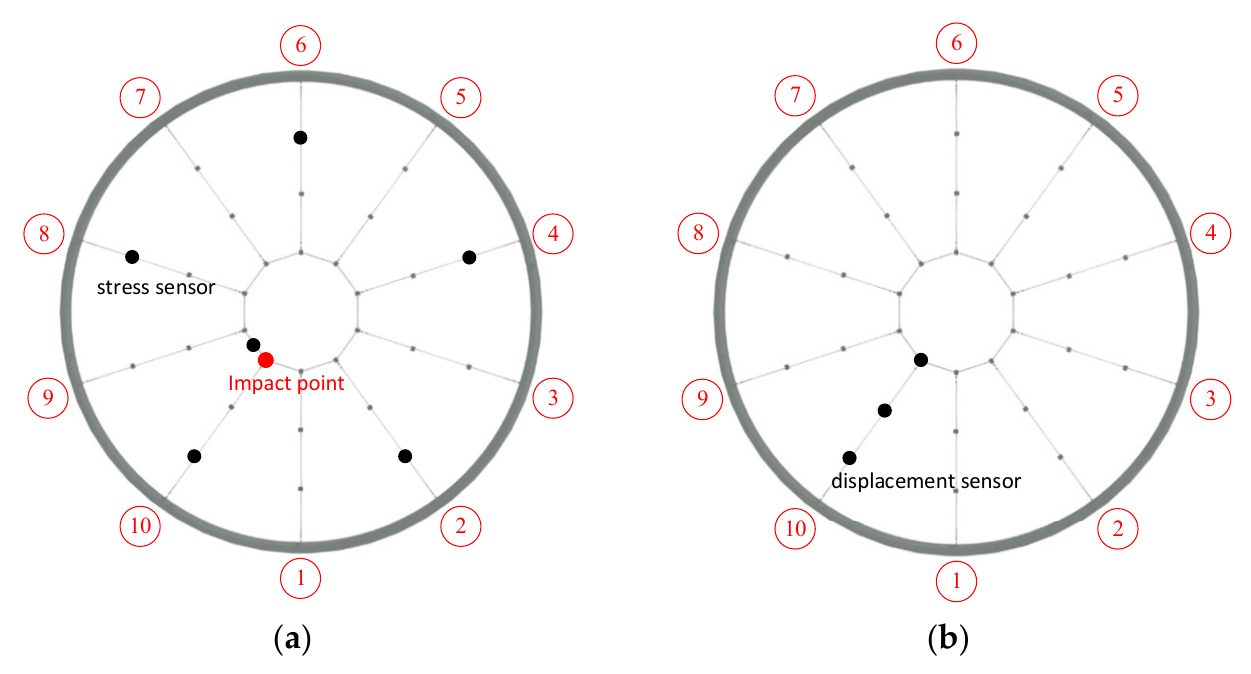
Figure 9. Loading device for impact test. ( a ) Cable monitoring point; ( b ) Displacement monitoring point.